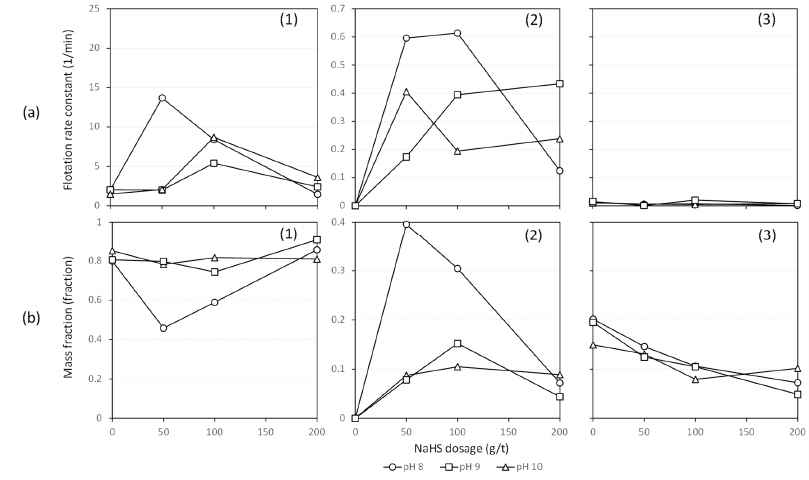
Figure 10. The chalcocite results of ( a ) flotation rate constants, (1) K 1 , (2) K 2 , (3) K 3 , and ( b ) mass fraction, (1) ϕ 1 , (2) ϕ 2 , (3) ϕ 3 , without NaHS and with NaHS dosages of 50 g / t, 100 g / t, and 200 g / t at pH 8, 9, and 10.